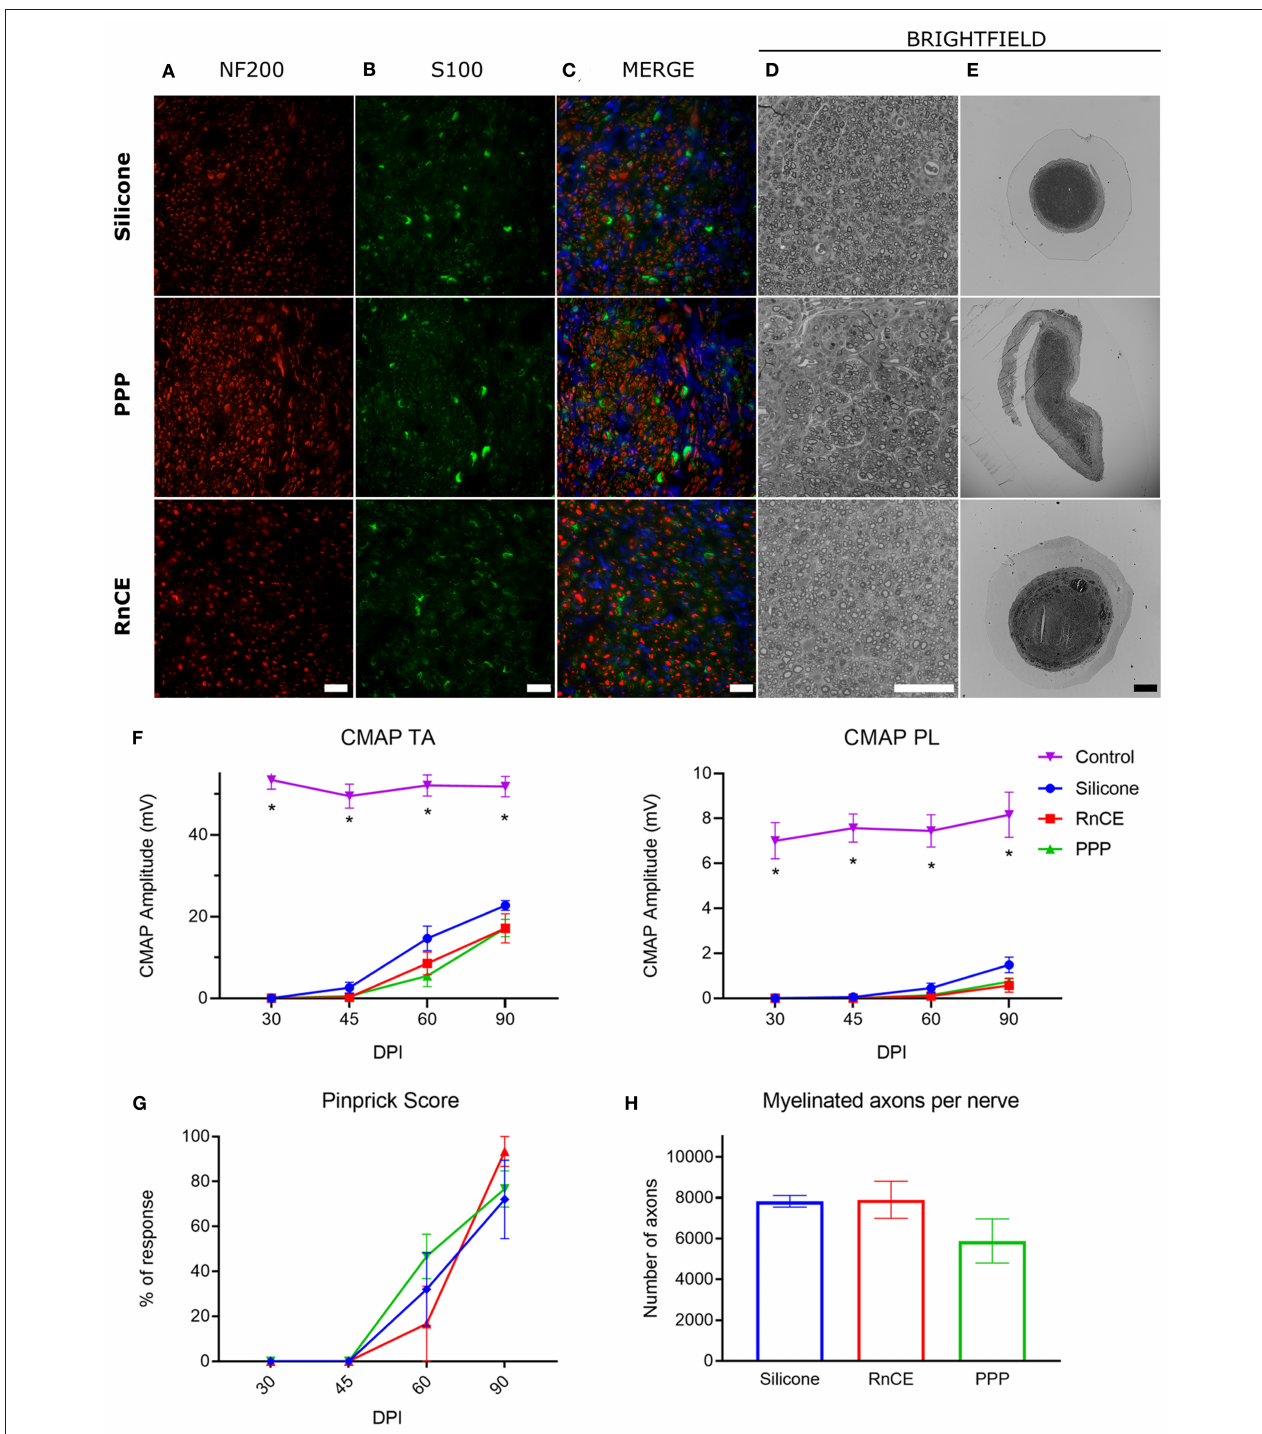
FIGURE 5 | Histological and electrophysiological evaluation of nerve regeneration. (A–E) Representative images of cross sectioned nerves repaired with silicone, PEDOT:PSS coated PO tube (PPP) and Regenerative nerve Cuff Electrode (RnCE) at 90 dpi. (A) NF200 (red) for axons; (B) S100 (green) for Schwann cells; (C) Merge of A and B with nuclear staining (DAPI, blue); (D,E) Brightfield images of regenerated nerves stained with toluidine blue labeling myelin sheaths at high (D) and low (E) magnification. Scale bar: 50 µ m in (A–D) , 200 µ m in (E) . (F) Amplitude of the CMAP of tibialis anterior (TA) and plantar interossei (PL) muscles along the 90 days follow-up after sciatic nerve section and repair. (G) Skin paw reinnervation tests by pinprick test. (H) Quantification of myelinated fibers in the sciatic nerve distal to the tube in the three tested groups. * p < 0.05 vs. other groups.